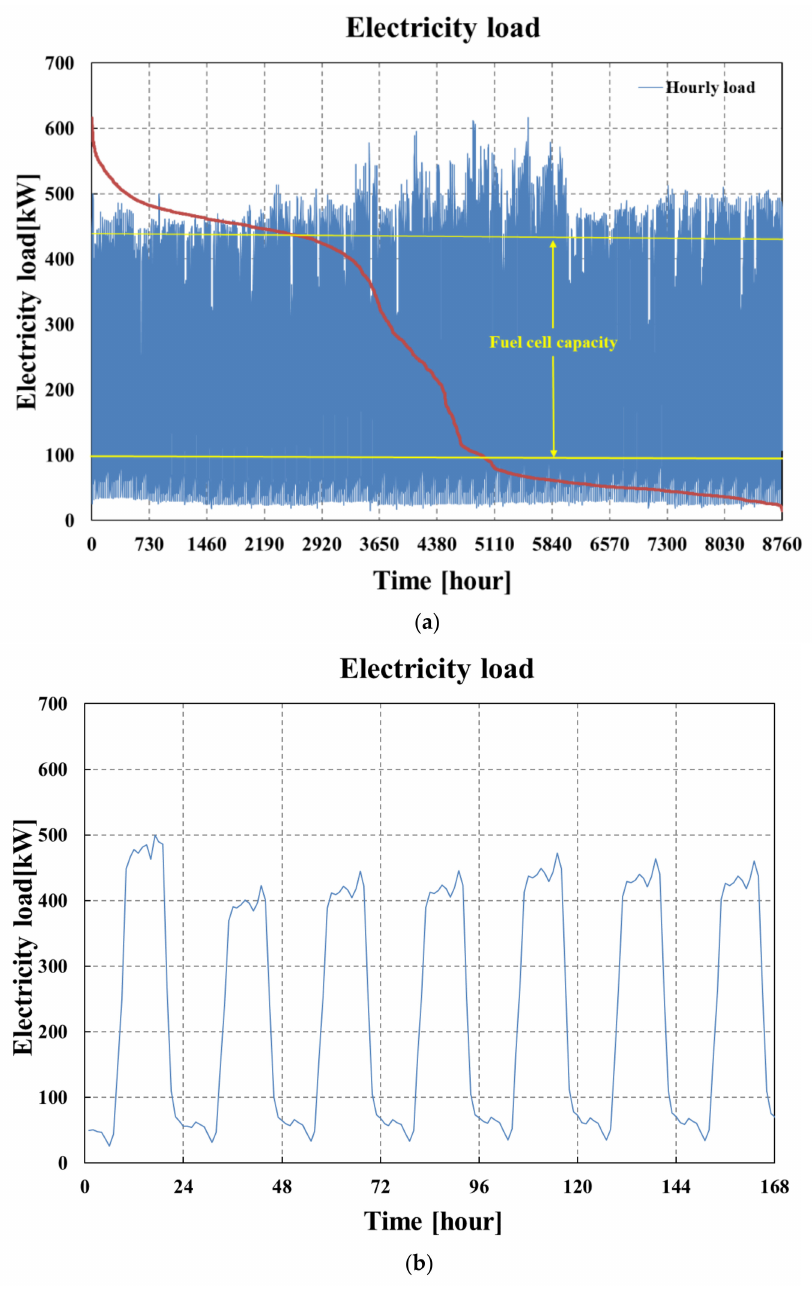
Figure 5. Measured electricity load (( a ) annual; ( b )